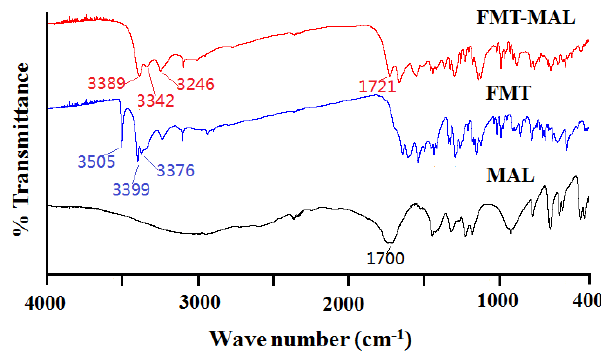
Figure 5. IR spectra of the FMT-MAL, FMT, and MAL.